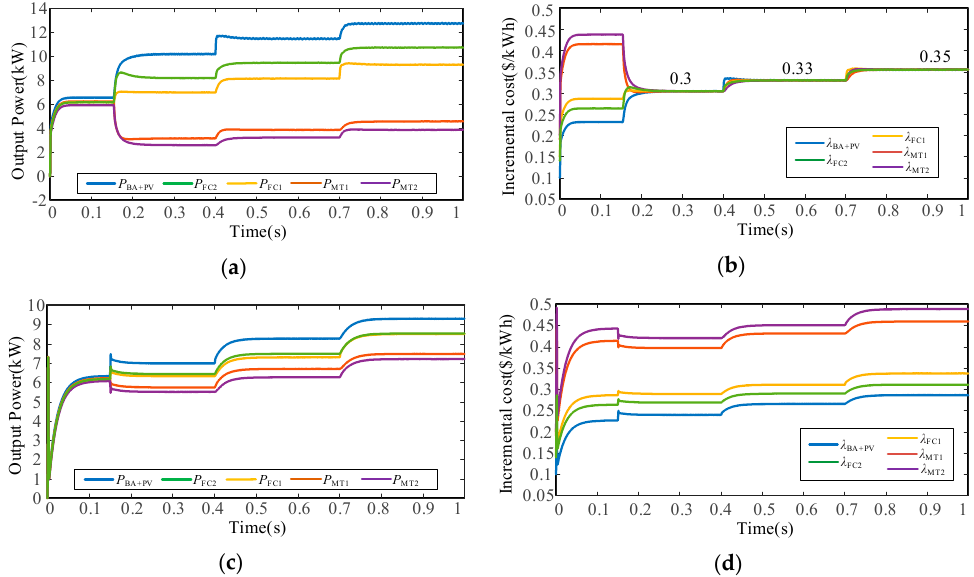
Figure 11. The comparison between the proposed distributed control and the decentralized control in tertiary level. ( a ) the output power of each generator based on the proposed scheme; ( b ) the incremental costs based on the proposed scheme; ( c ) the output power of each generator based on the non-linear scheme; ( d ) the incremental costs based on the non-linear scheme.